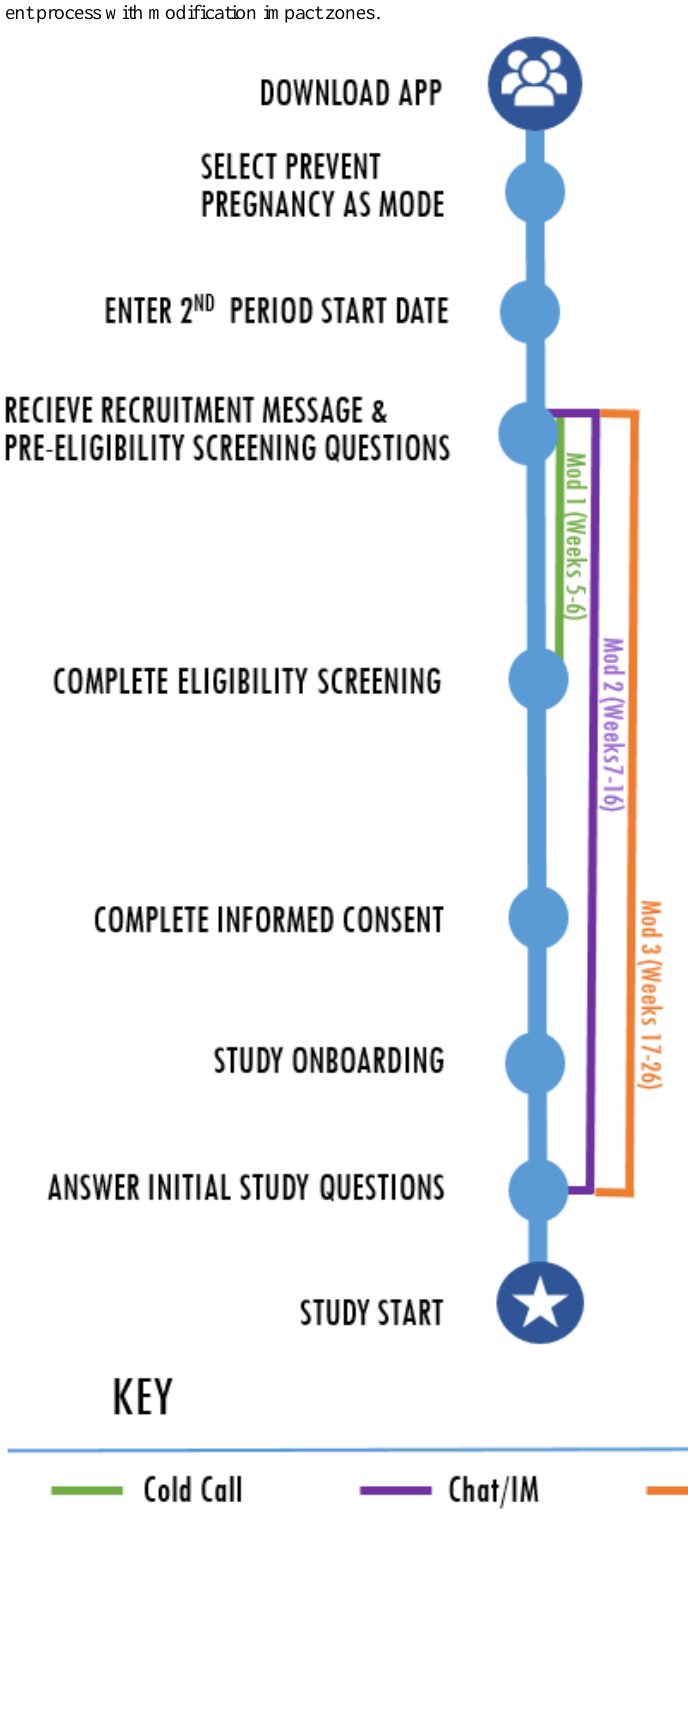
Figure 2. Recruitment process with modification impact